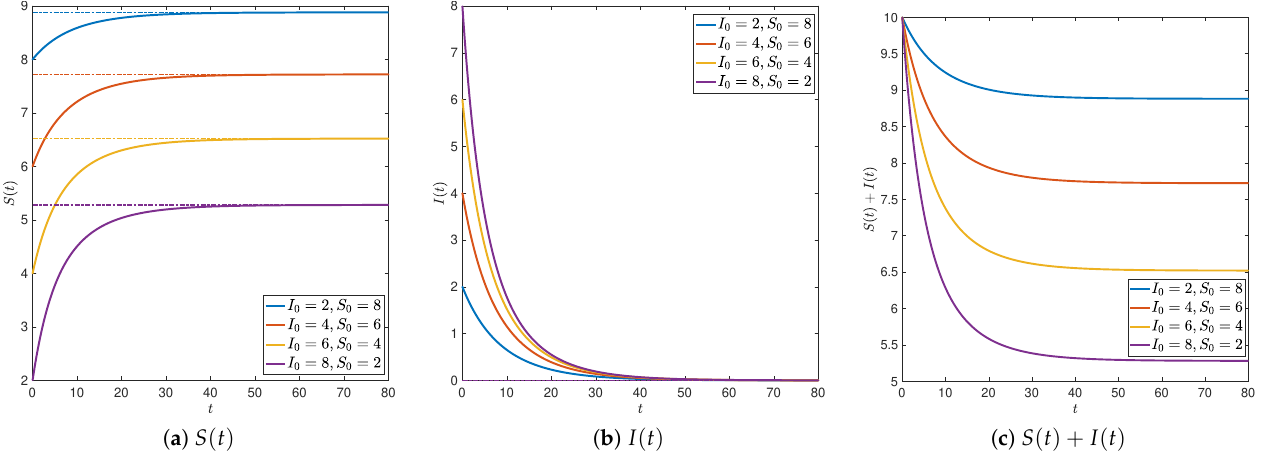
Figure 6. Numerical solutions to (2) for α = 0.5, β = 0.1, γ = 0.2 and M ( α ) ≡ 1 as I 0 and S 0